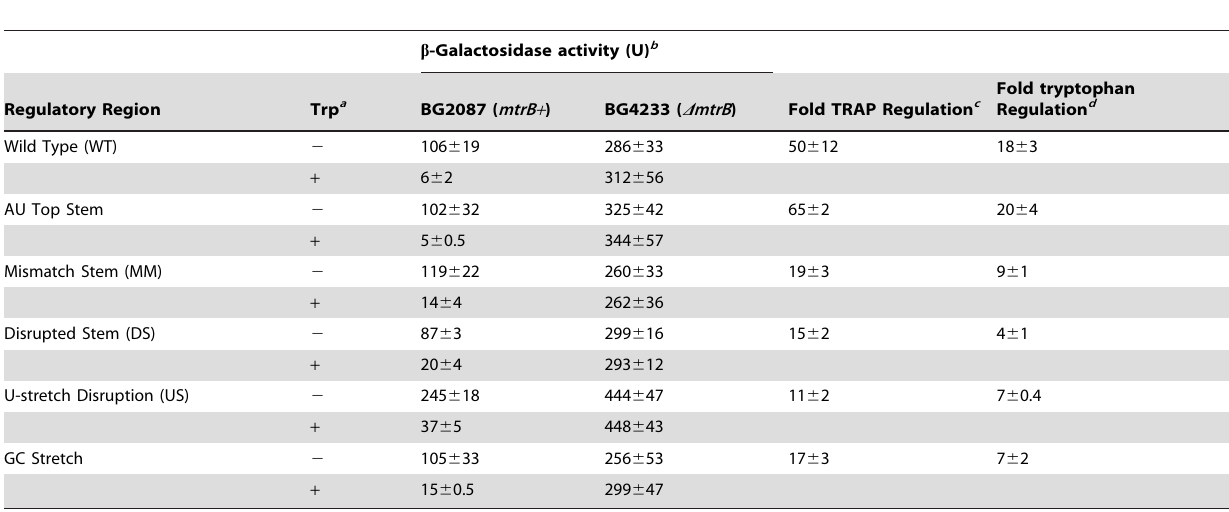
Table 1. Effects of mutations in the trp attenuator on TRAP-mediated transcription termination invivo .